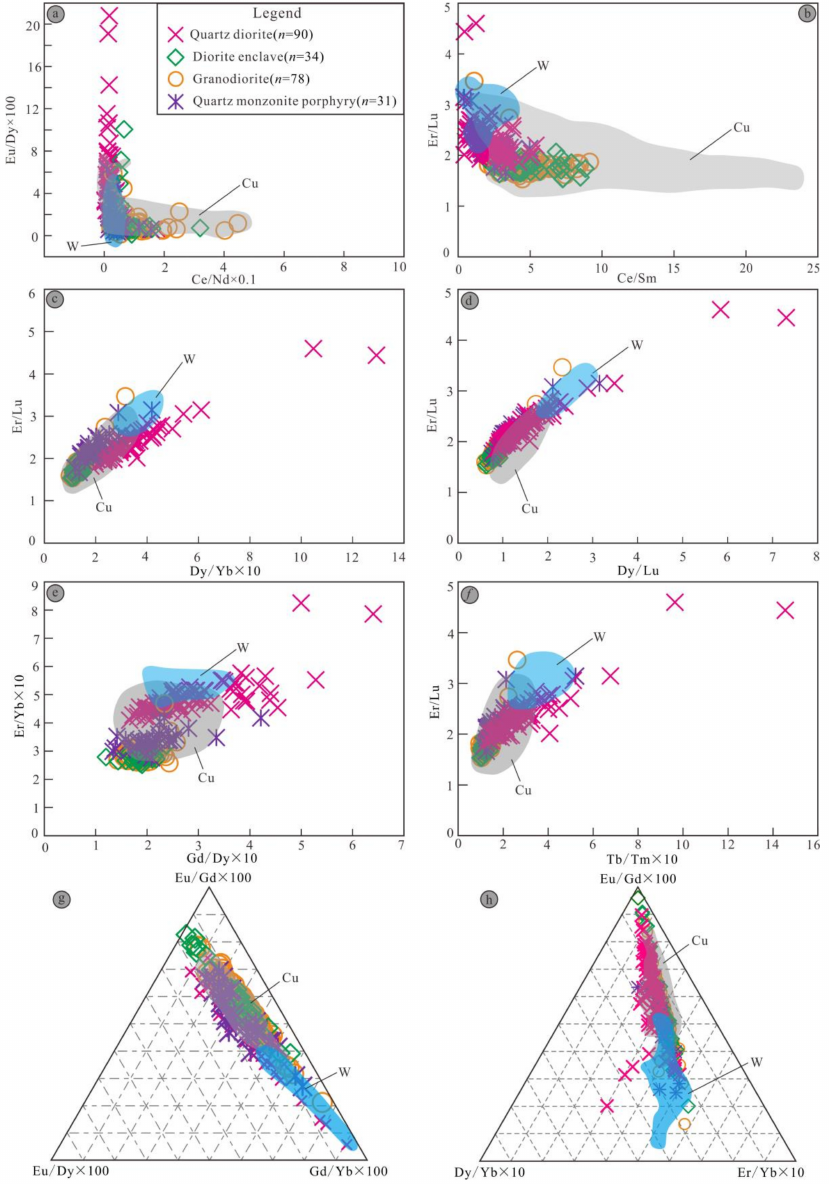
Figure 18. The binary ( a – f ) and triangular ( g , h ) metallogenic potential discriminant diagrams of zircon trace elements from Yangla granitoid plutons. The dioritic enclaves, granodiorite, and quartz monzonite porphyry zircons data from Ref. [3]. The region data of Cu and W referenced the